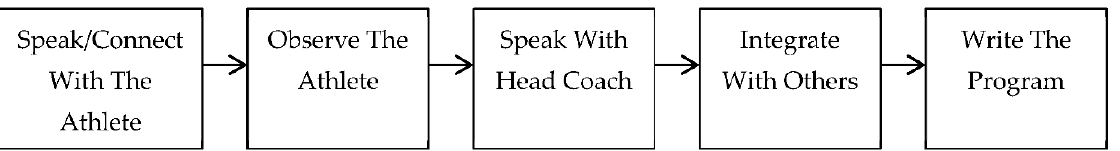
Figure 1. Task diagram illustrating the stages associated with HLC decision making when designing training programs.